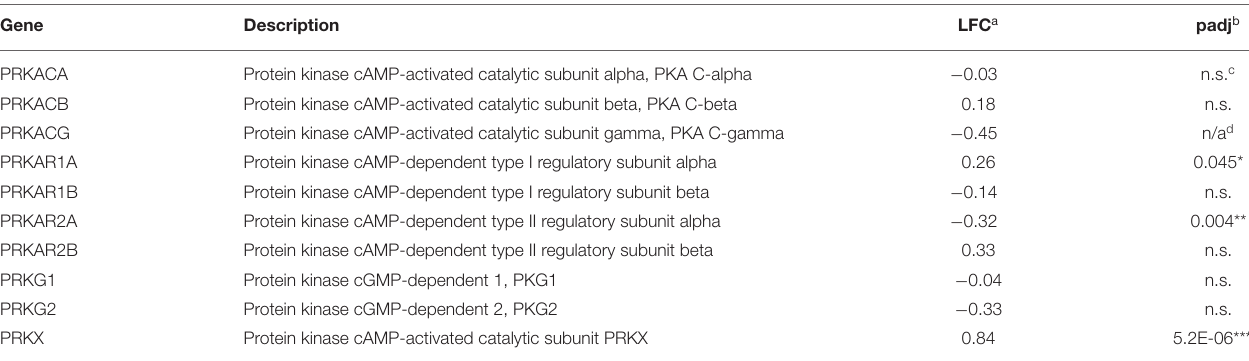
TABLE 2 | Differential gene expression of PKA, PKG, and PRKX.